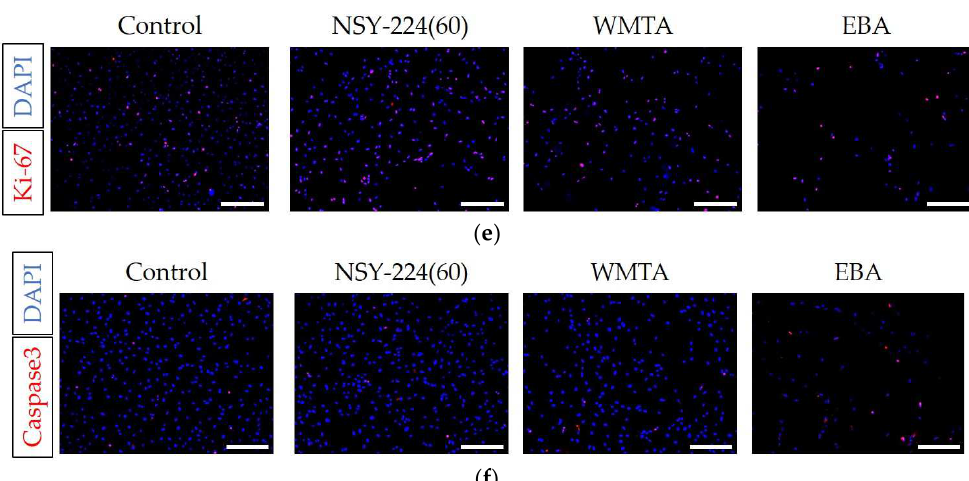
Figure 3. Effects of cements on morphology, viability, proliferation, and apoptosis of HCEMs. ( a , c ) Phase-contrast images of HCEMs cultured with each cement for 72 h. ( b ) Effect of mixing ratio of NSY-224 on the number of viable cells. ( d ) Effect of various materials on the number of viable cells. ( e , f ) Fluorescent images of Ki-67 ( e ) or Caspase3 ( f ) positive immunostaining in cells cultured with each cement for 60 h. Scale bars, 500 µm. The data are expressed as means ± SDs ( n = 3); ns: not significant; * p < 0.05 , ** p < 0.01 , *** p < 0.001.